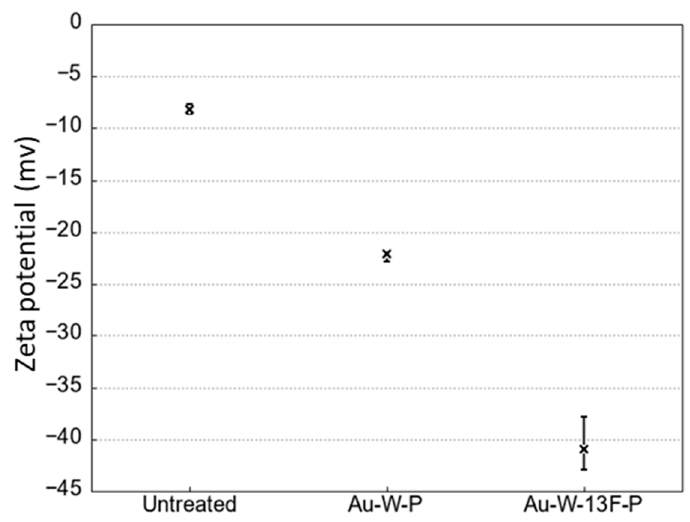
Figure 7. Zeta potential of untreated and modified PTFE samples with water at a constant pH